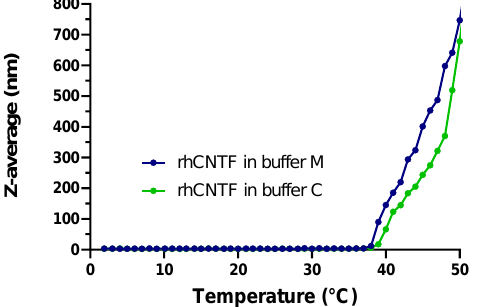
Figure 6. Thermal aggregation curve of freshly purified rhCNTF. Aggregation of purified rhCNTF was measured by following the estimated Z-average (nm) with dynamic light scattering (DLS) as a function of temperature. Appearance of high molecular weight (HMW) species is observed at temperatures above 38 °C in both